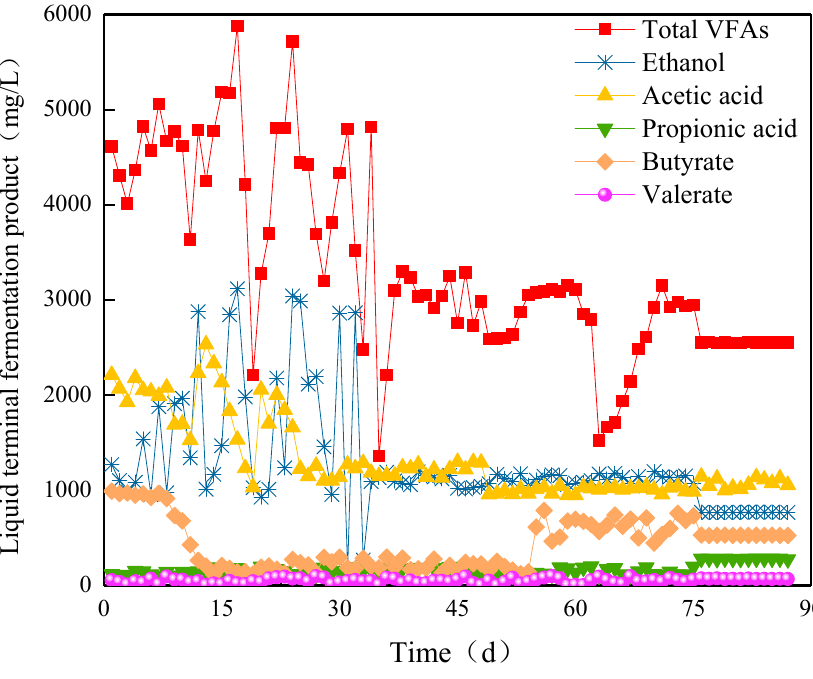
Figure 10. Ethanol and VFAs yields in Compartment III.